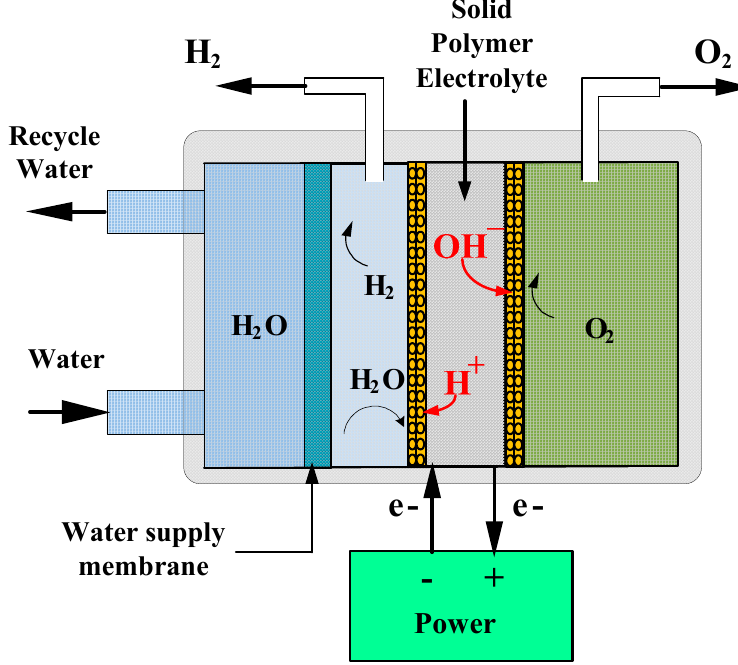
Figure 3. Schematic of electrolytic cell.